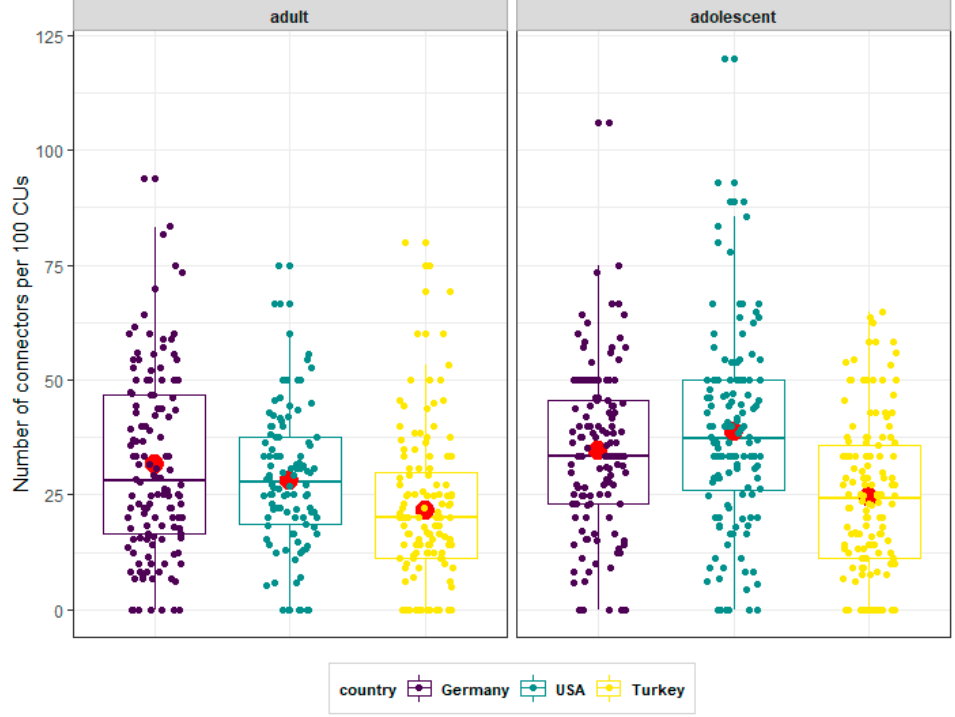
Figure 3. Box plots representing connector use per 100 CUs with the focus on age.